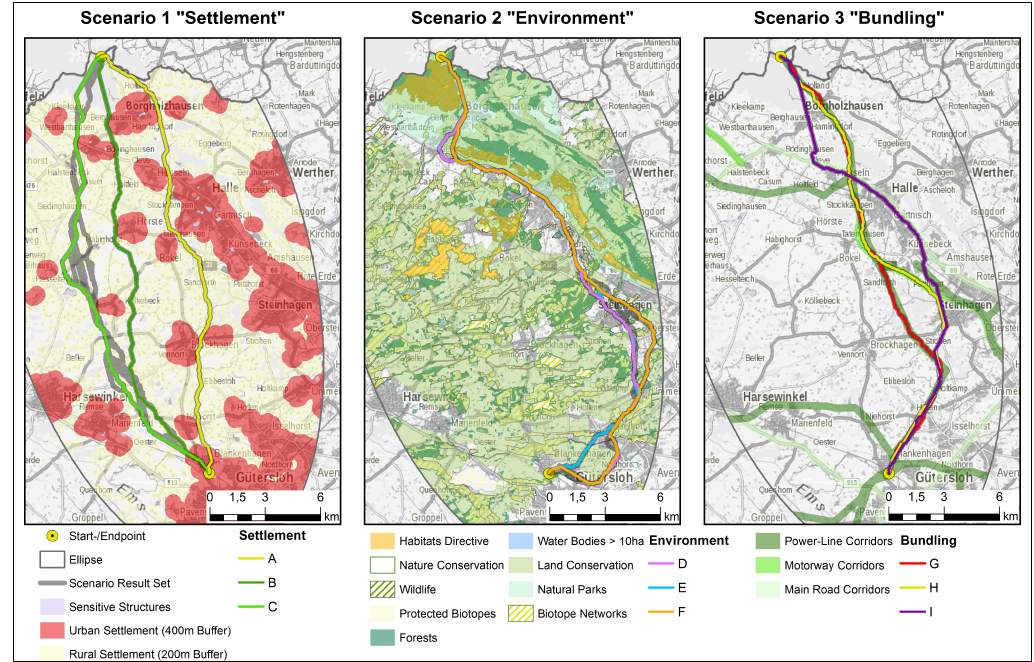
Figure 9. Visualisation of exemplary results from interaction with the approximated Pareto-front.